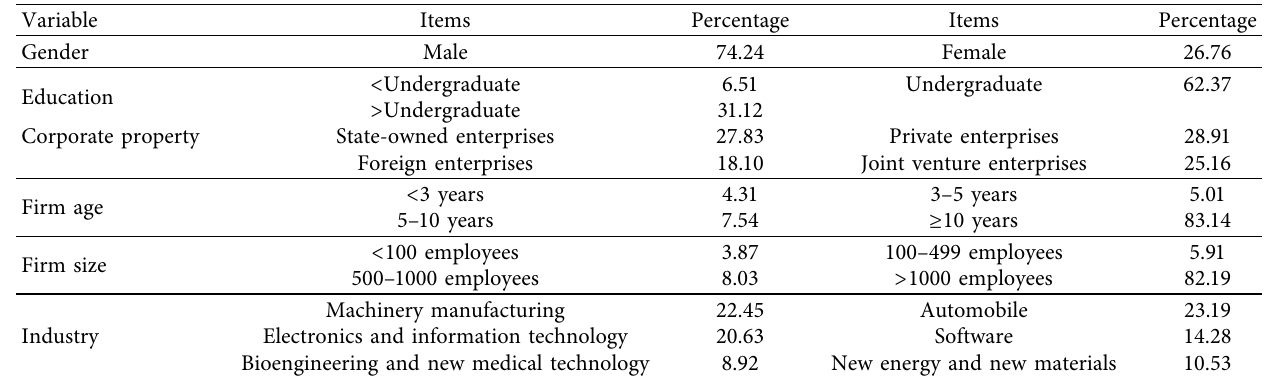
Table 1: Distribution of sample features.